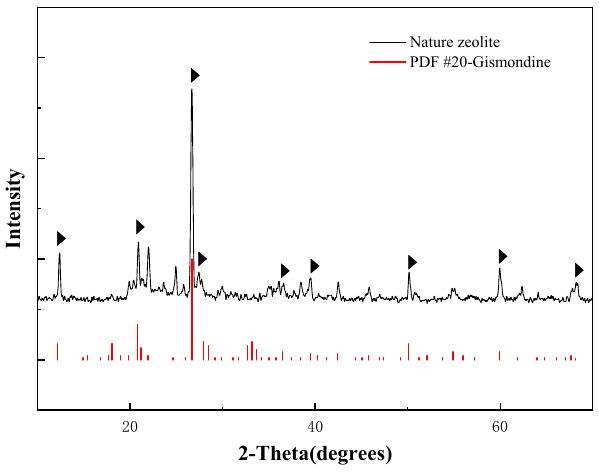
Figure 3. XRD measurement of the unmodified natural zeolite.